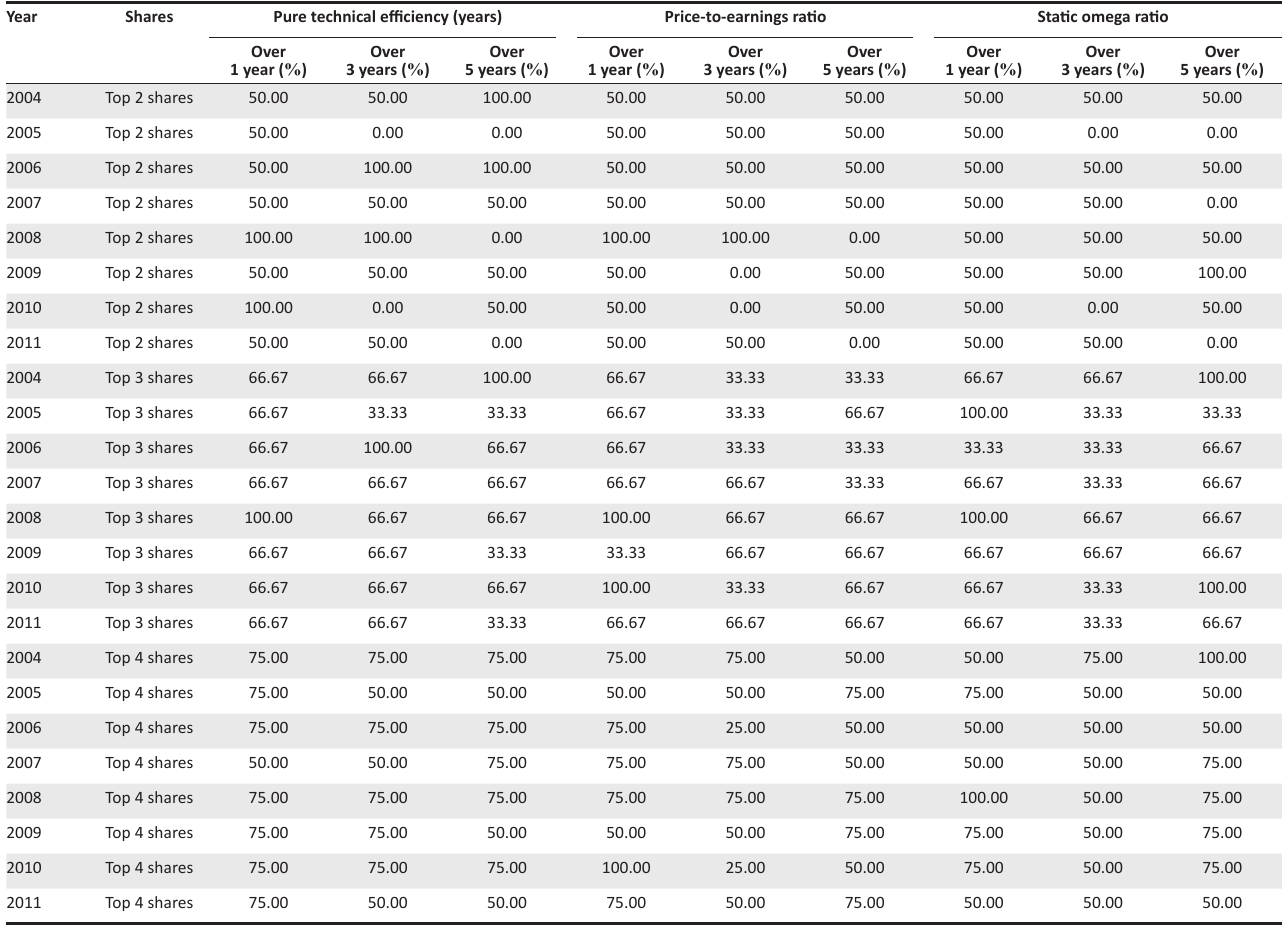
TABLE 2-A1: Average ability of pure technical efficiency (VRS), the P/E ratio and static Omega ratio to select the top performing banking shares.